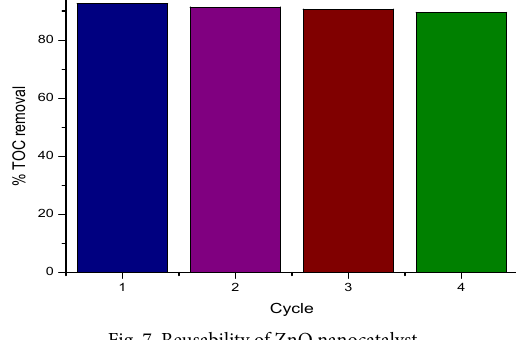
Fig. 5. Effect of catalyst concentration on % TOC removal of textile industry effluent at pH-7 and contact time 160 min